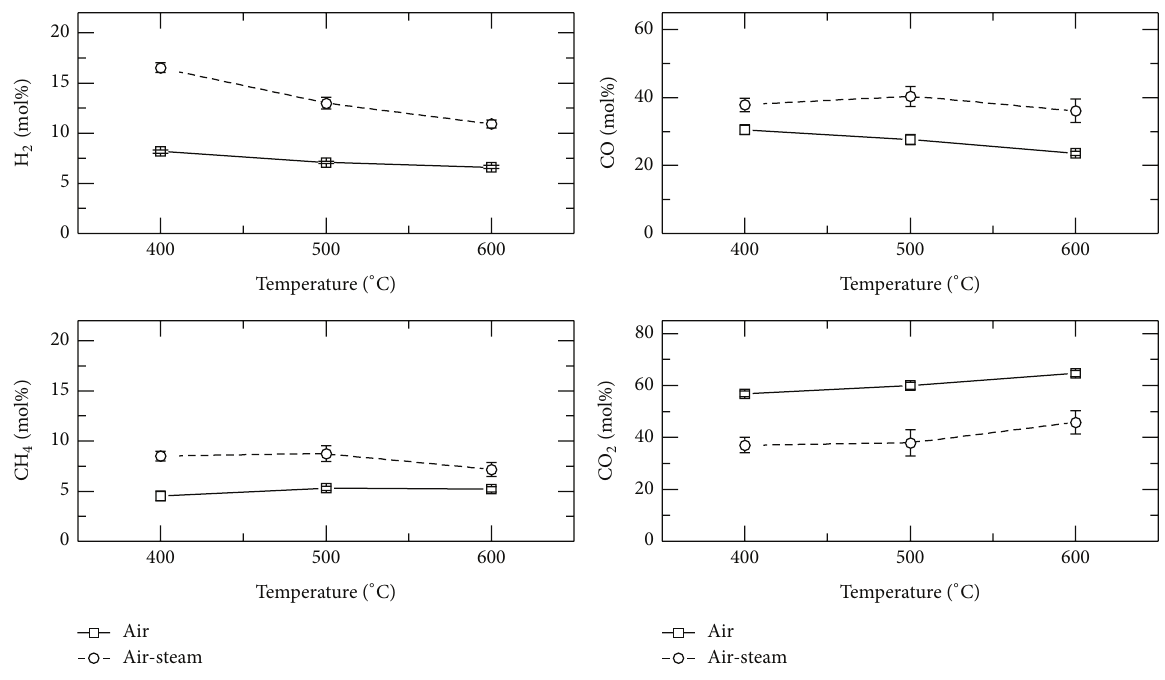
Figure 2: Effect of gasifying medium on gas composition at different